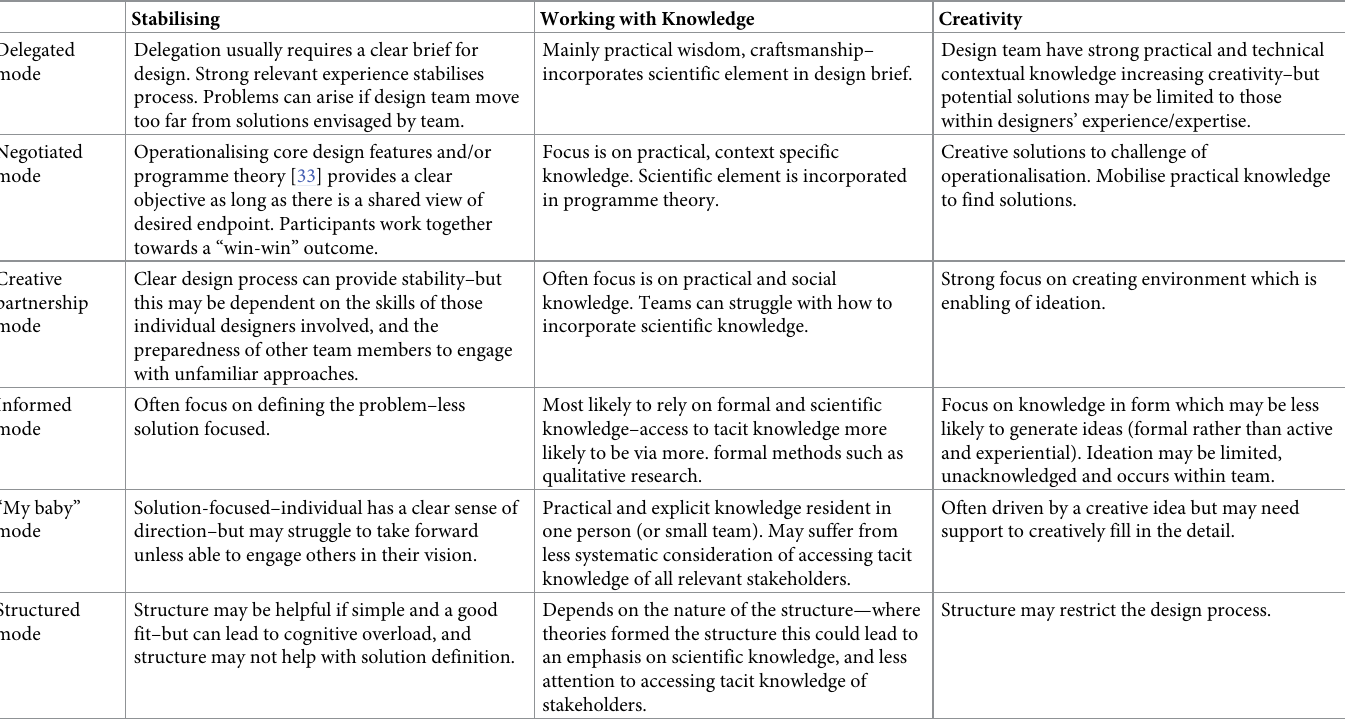
Table 2. Modes of intervention design and themes relating to the challenges of the intervention design process.